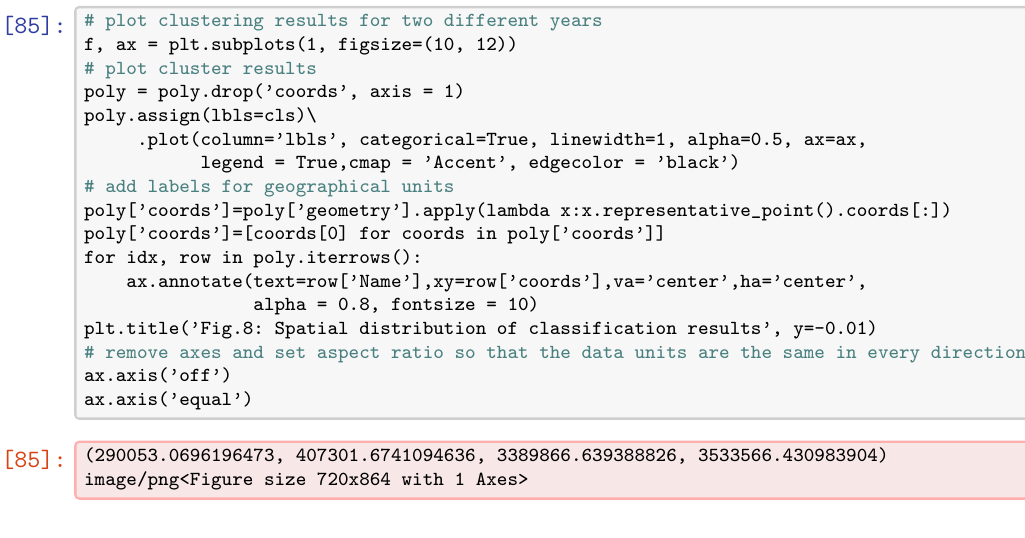
Figure 7: Visual representation of patterns extracted from k-mean